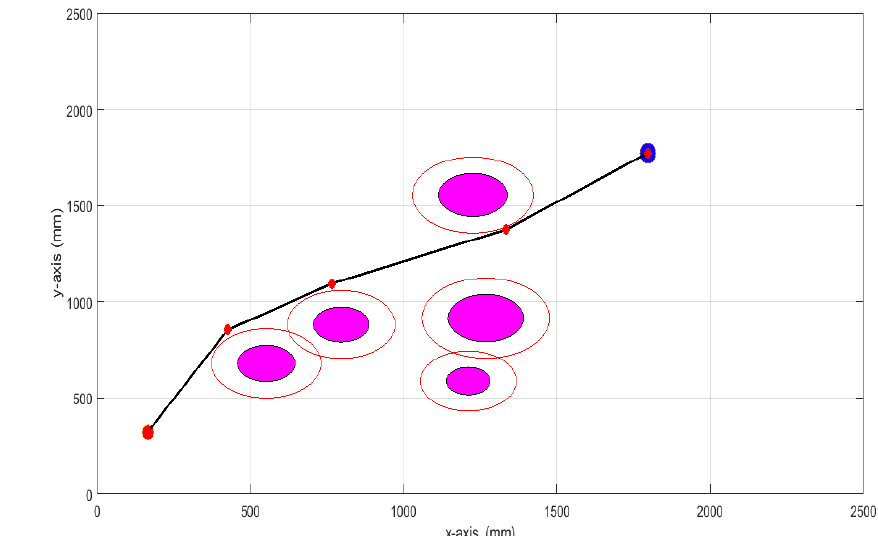
case one, the optimal path of the GWO is equal to